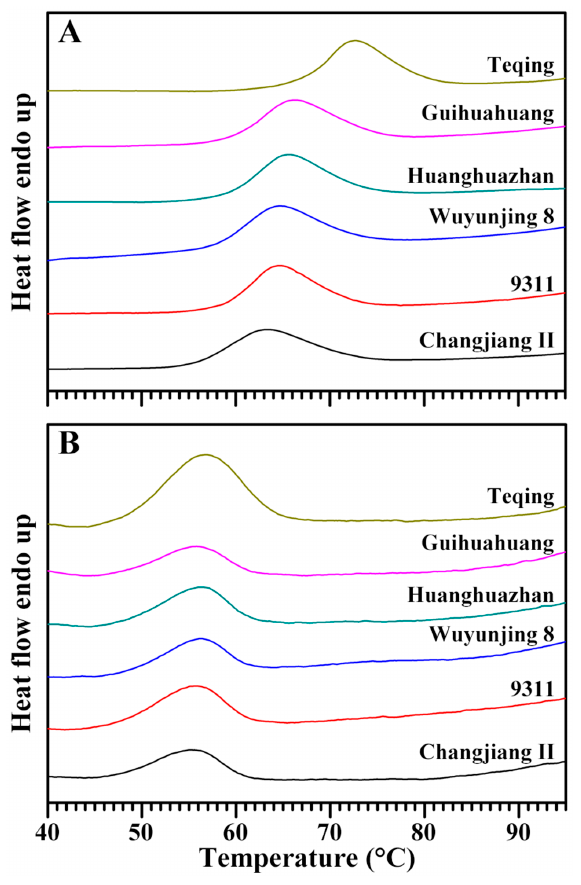
Figure 4. DSC thermograms of native starches ( A ) and retrograded starches ( B ).